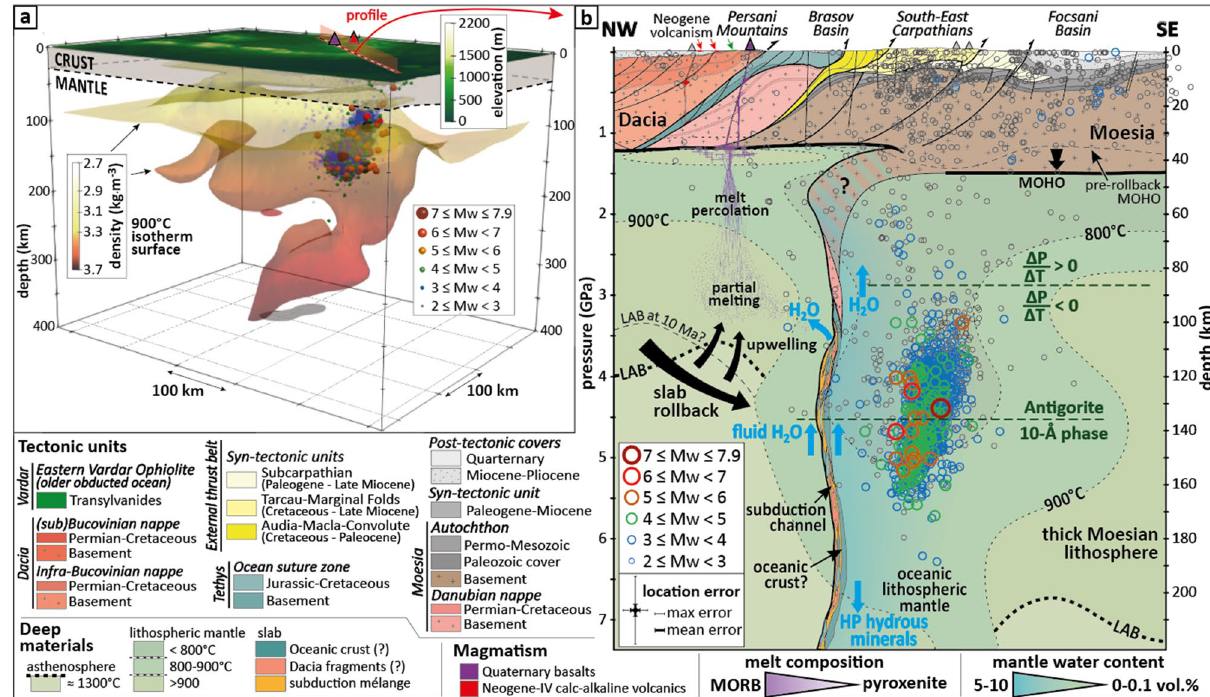
Figure 2. Geometry of the Vrancea slab and seismicity depth distribution. ( a ) 3D model showing the geometry of the slab, using the shape of the 900-°C isotherm extracted from the most recent thermal model 38 . Open circles show the hypocentre locations of the entire seismic dataset (Mw ≥ 2, year ≥ 1940). The location of the synthetic cross-section ( b ) as well as the locations of the PVF and Ciomadul are located on top of the 3D model (see text); ( b ) Interpreted cross-section of the Vrancea slab normal to the seismic body (scale 1:1). The profile from NW (46.2; 25.2) and SE (45; 27.3) is located on ( a ). All earthquakes shown on the cross-section are located at < 10 km from the profile. The position of the Lithosphere-Asthenosphere Boundary (LAB) is from Dérerová et al. 59 The pre-rollback position of the Moho is from Maţenco et al. 9 , and the former LAB position (10 Ma) is proposed following the rollback scenario. The 800-°C and 900-°C isotherms are extracted from the thermal model. For profile location, see ( a ) and Fig. 1. The ΔP/ΔT refers to the Clapeyron slope of antigorite dehydration, which is positive for P < 2.8 GPa and negative for P > 2.8 GPa. Location uncertainties are represented on ( b ), with vertical and horizontal errors of 5.2 and 3.4 km, support that it is still active 3,7 . The volcanic chain has been active over the Neogene, with very last activity nowa- days at the Ciomadul cone, while older volcanism (1.5 Ma) affected the Apuseni area 32 . The Persani Volcanic Field (PVF 7 is offset ≈ 30 km westward from the calc-alkaline volcanic chain 32 . Delamination ‐ induced magmatism is is fully consistent with the rollback of an oceanic slab between the Miocene and the Quaternary 7 , also supported by a detailed study of the eastward migration of both uplift and subsidence during this period 9 .